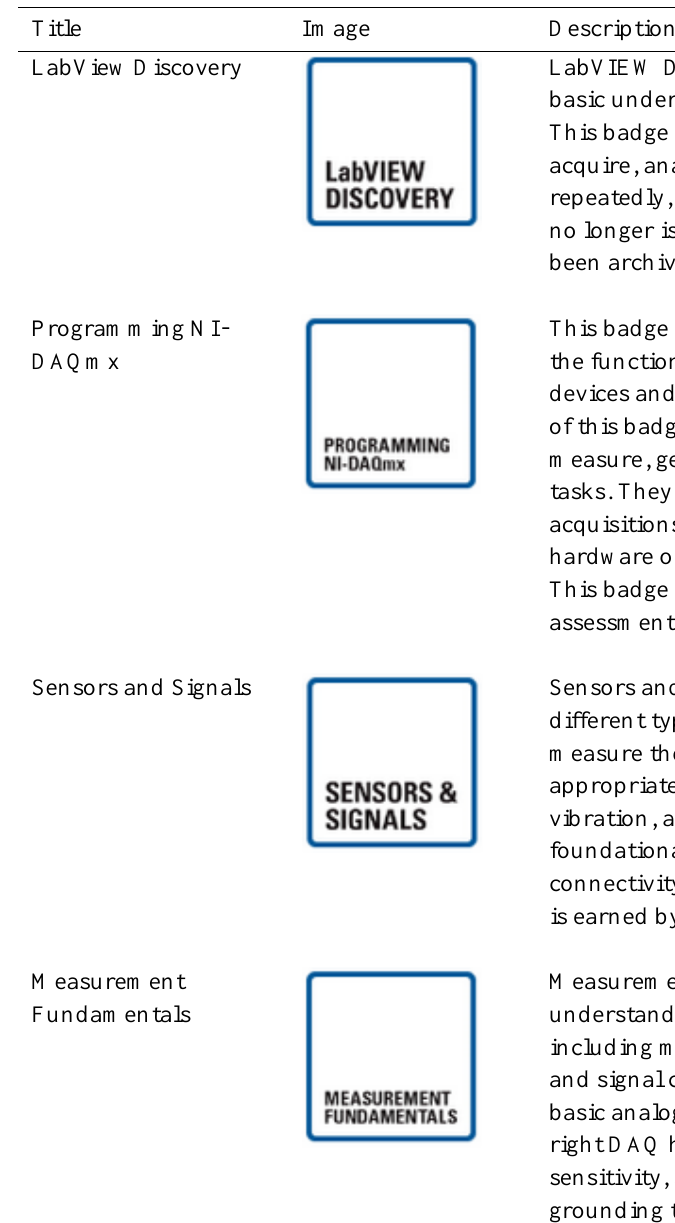
Seven Badges Included in National Instruments Badge Pilot